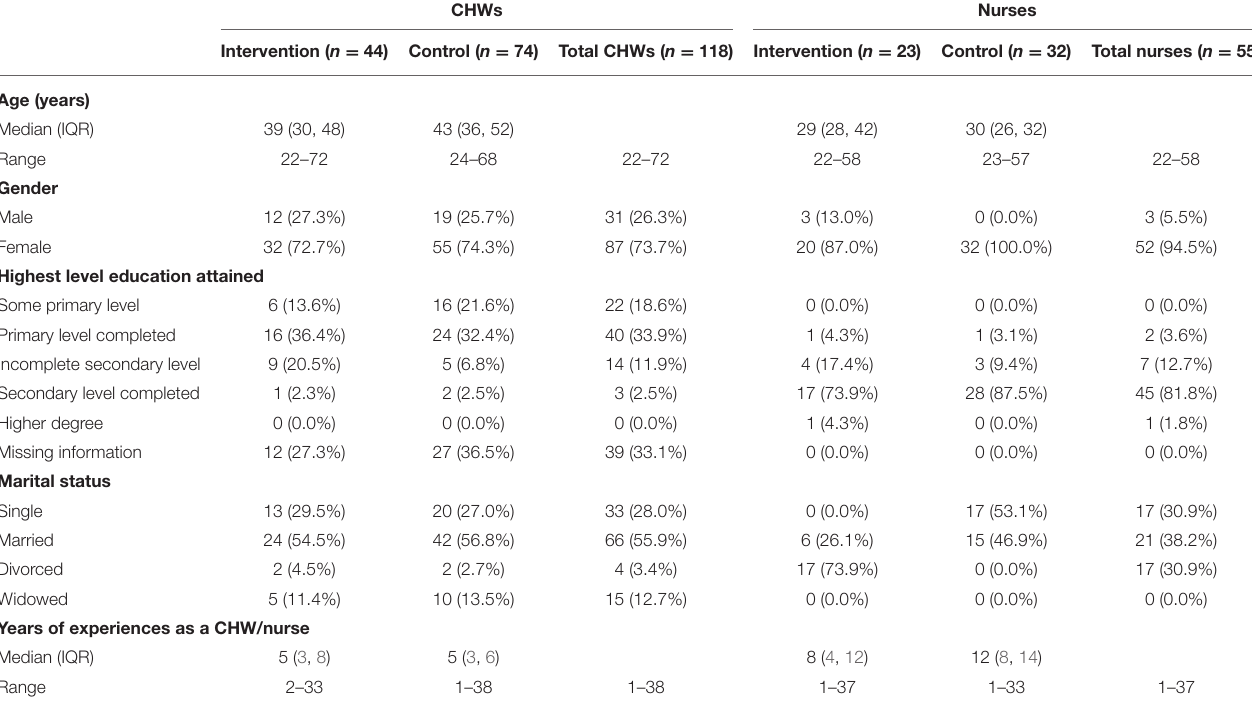
TABLE 1 | Participant’s characteristics.